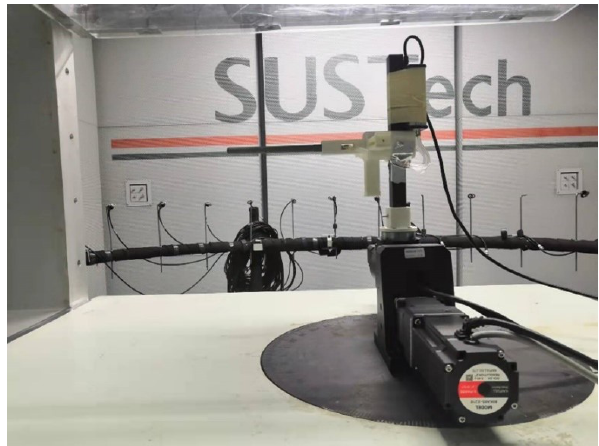
Figure 7. The wind-tunnel test